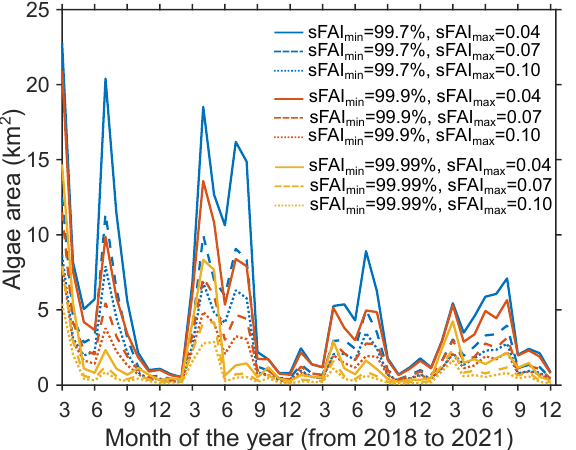
Figure 5. Monthly variations in the floating macroalgae area around Japan from 2018 to 2021. The floating macroalgae in all the subareas in Figure 2 were considered. However, macroalgae within four pixels from land (and thus invalid) pixels were